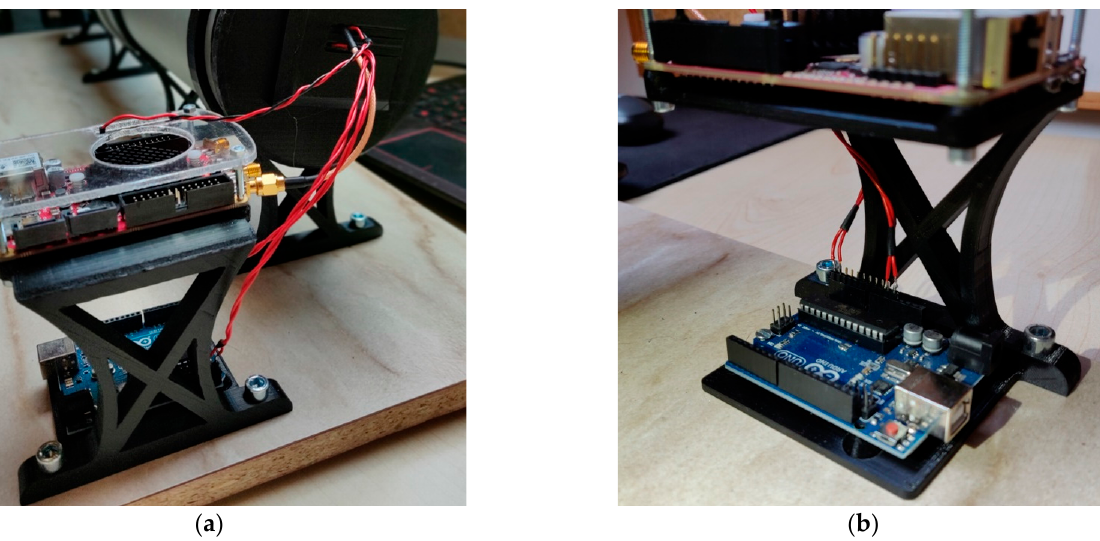
Figure 9. Microcontroller and multifunctional measurement device Red Pitaya holder: ( a ) Multifunctional measurement device Red Pitaya—above; ( b ) Microcontroller Arduino—below.